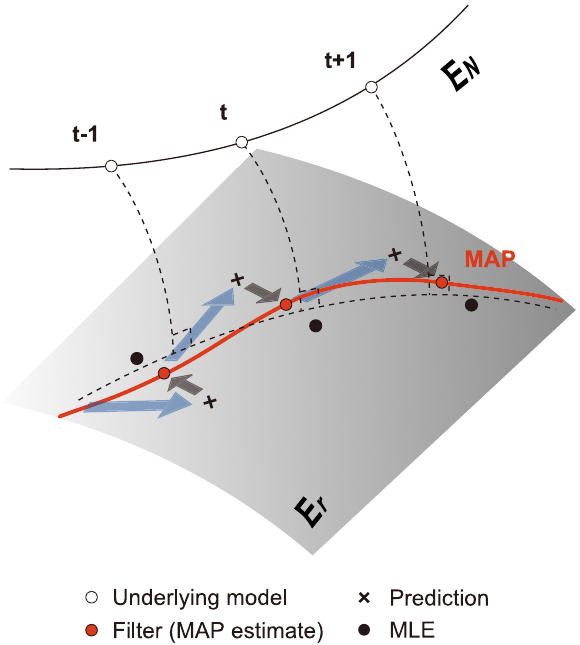
Figure 1. Geometric view of recursive filtering in subspace E r . Each point in this figure represents a probability distribution, p ( x ) , of an N -tuple binary variable, x ~ ( x 1 , x 2 , ... , x N ) . The underlying time- dependent model is represented by white circles in the space of E N . The dashed lines indicate projections of the underlying models to the model subspace, E r . The maximum a posteriori (MAP) estimates of the underlying models projected on subspace E r were obtained recursively: Starting from the MAP estimate at time t { 1 (filter estimate, red circle), the model at time t is predicted based on the prior knowledge of the state transition, Eq. 8 (blue arrow, prediction; black cross, a predicted distribution). The maximum likelihood estimate (MLE, black circle) for the spike data at time t derived by Eq. 4 is expected to appear near the projection point of the underlying model at time t in E r . The filter distribution at time t is obtained by correcting the prediction by the observation of data at time t (black arrow). The filter estimation at time t is used for predicting the model at time t z 1 and so on. This recursive procedure allows us to retain past information while tracking the underlying time-dependent model based on the current